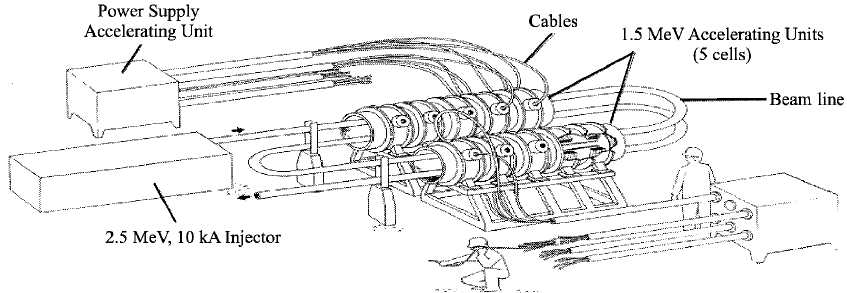
FIG. 9. Spiral line recirculating induction accelerator (two beam passes are shown illustrating actual 9.5 MV, 2 kA proof of